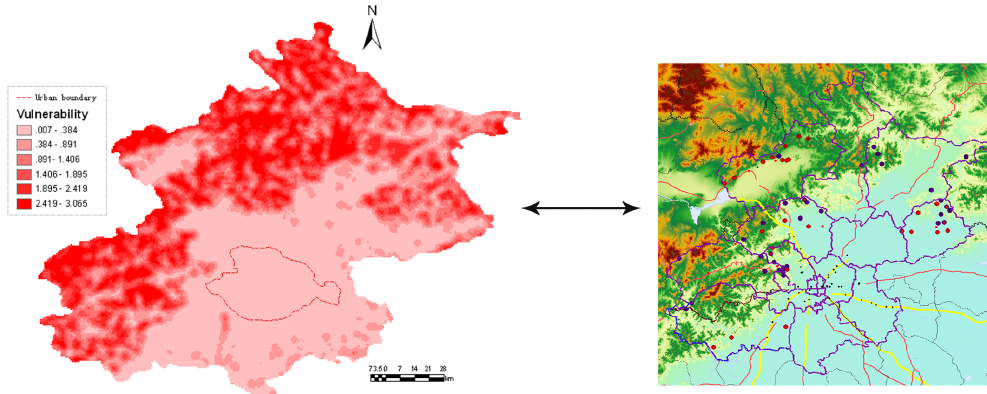
Figure 7. Vulnerability zoning calculated by the model and the corresponding topography in